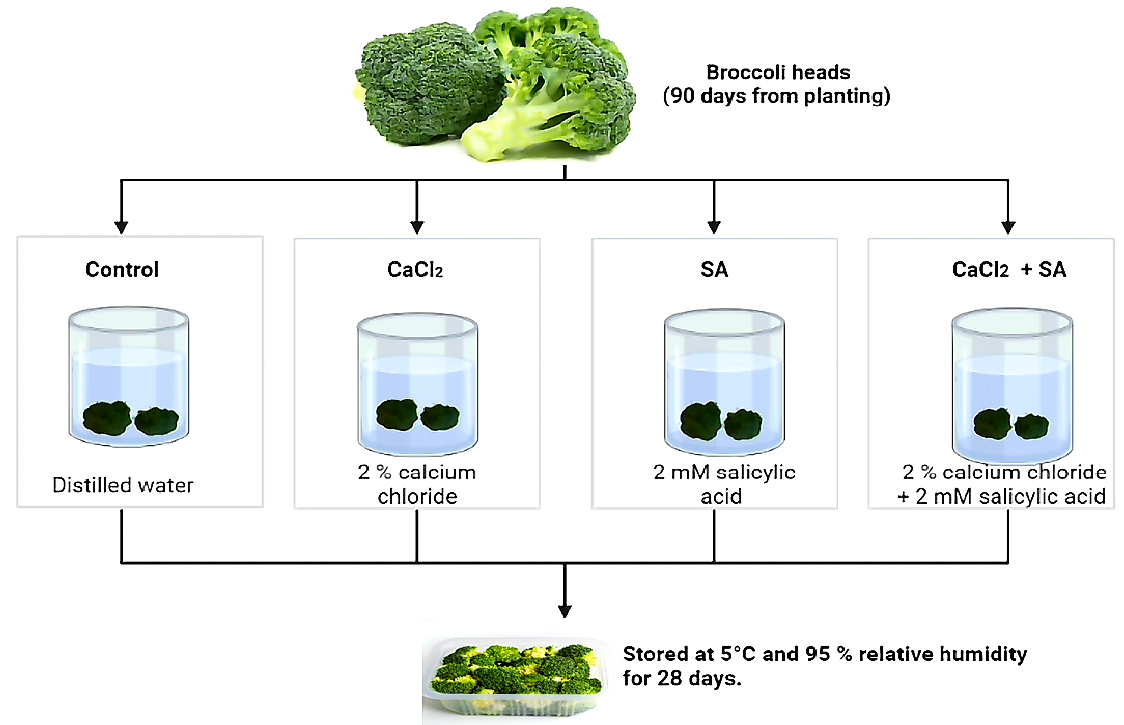
Figure 1. Treatments schema and their